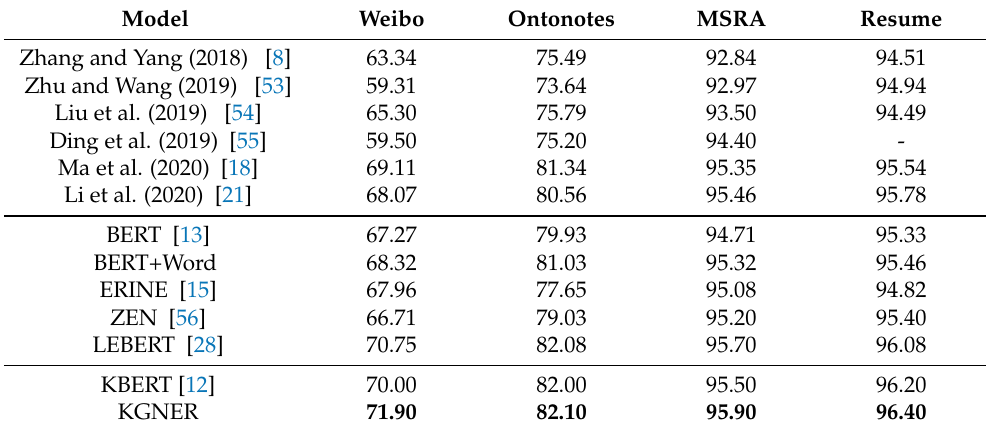
Table 2. Four datasets results ( F